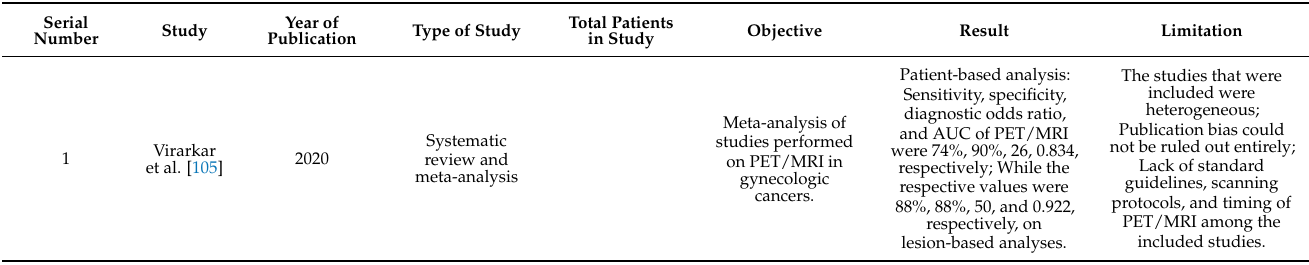
Table 9. Characteristics of PET/MRI